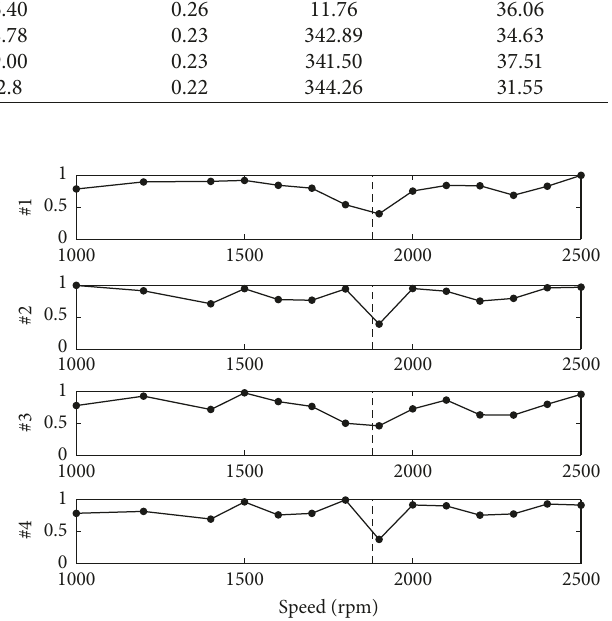
Figure 7: The useful information ratio curve of measuring planes A and B. #1–#4 correspond to the four measuring